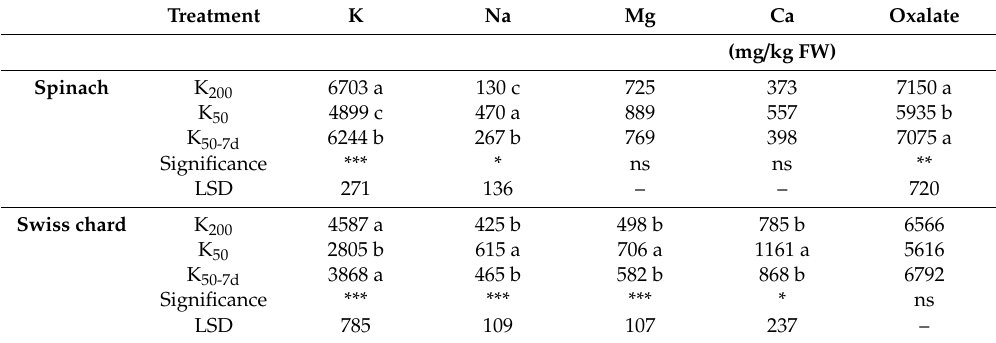
Table 4. E ff ects of potassium (K) concentration in nutrient solution (NS) and duration of K restriction on Na, K, Mg, Ca, and oxalate content in edible parts of hydroponic spinach and Swiss